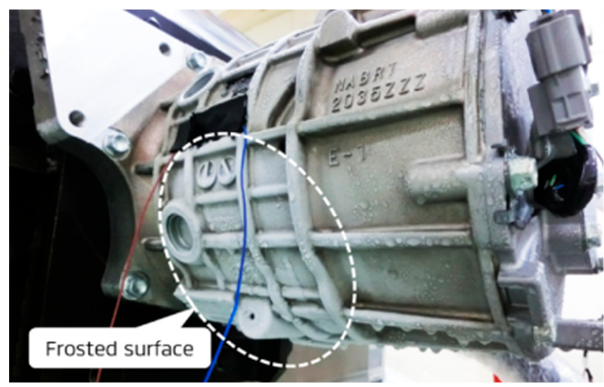
Figure 7. Frosted motor surface by refrigerant cooling.